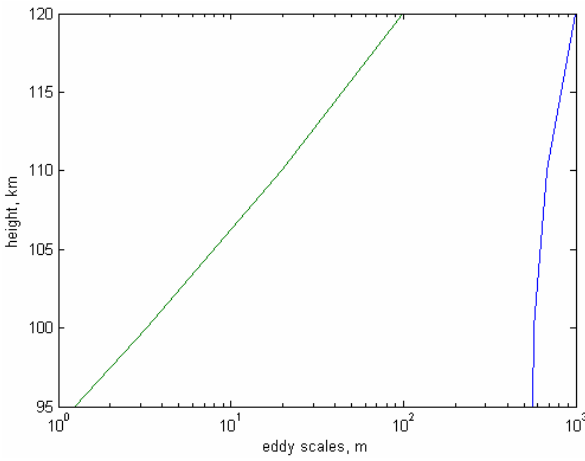
Fig. 1. Height distribution of the eddy scale maximum and mini- mum for eddy Figure 1. Height distribution of the eddy scale maximum and minimum for eddy diffusion.